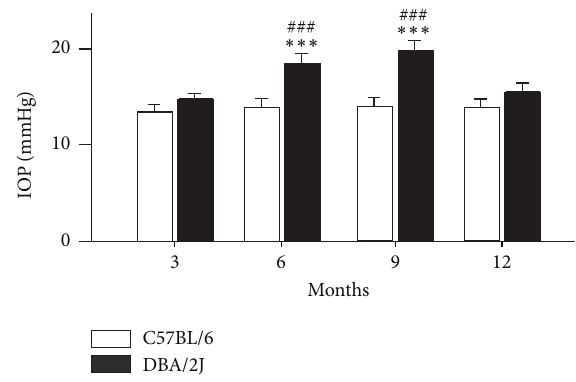
Figure 1: Changes of IOPs in C57BL/6 and DBA/2J mice at various ages. Bar chart showing changes of the average IOPs in C57BL/6 and DBA/2J mice at ages of 3 ( 𝑛 = 24 ), 6 ( 𝑛 = 18 ), 9 ( 𝑛 = 12 ) and 12 ( 𝑛 = 6 ) months. All data are presented as mean ± S.E.M. ∗∗∗ 𝑃 < 0.001 versus 3-month-old C57BL/6 mice; ### 𝑃 < 0.001 versus age- matched C57BL/6